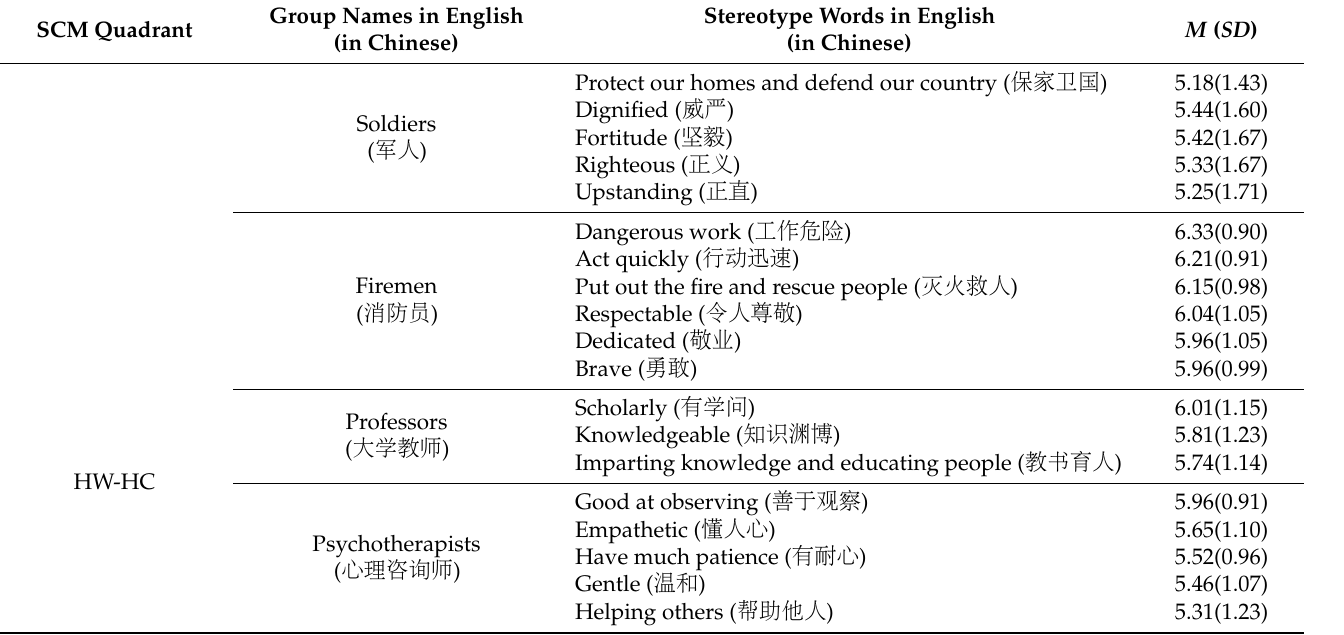
Table 7. The descriptive data of ratings on typicality of stereotype words for 24 typical social groups. Group Names in SCM Quadrant